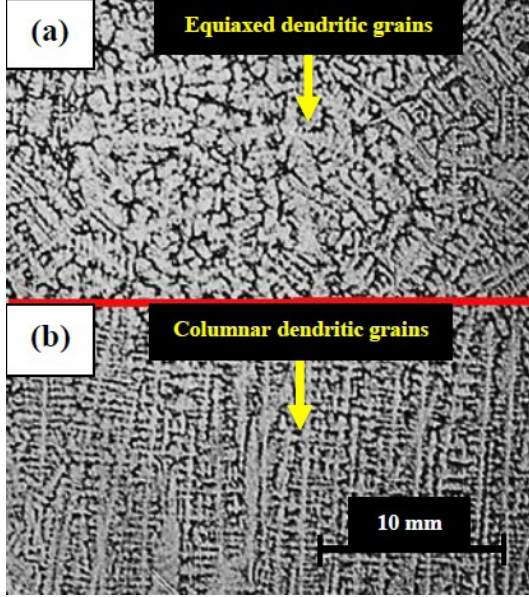
Figure 1. Example of macrostructures of (a) Equiaxed dendritic grains (b) Columnar dendritic grains 28